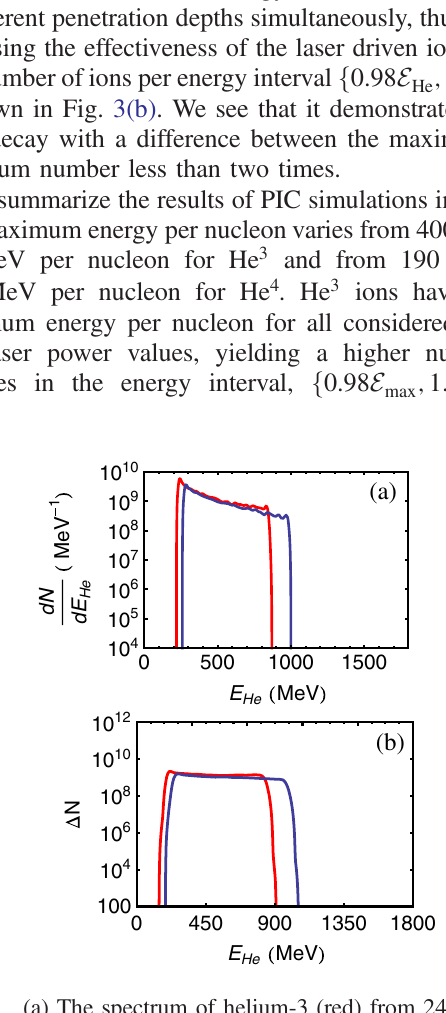
FIG. 3. (a) The spectrum of helium-3 (red) from 240 MeV to 860 MeV and helium-4 (blue) ions from 280 MeV to 1 GeV accelerated in the forward direction; (b) The number of helium-3 (red) and helium-4 (blue) ions per energy interval, 0 . 98 E < E < 1 . 02 E . The laser pulse power is 1 PW, the He He He target thickness is 60 λ